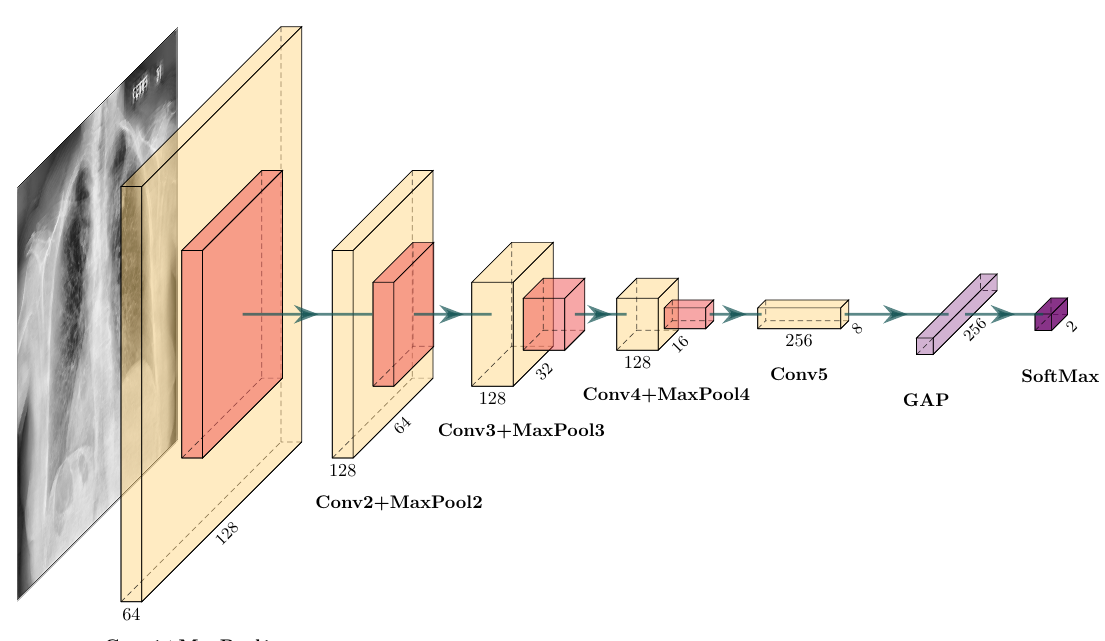
Figure 2. Diagram of COVID-XNet. It consists of five convolutional layers (Conv), four max pooling layers (MaxPool), a GAP layer, and a softmax layer. Conv1, Conv2, and Conv3 use five × five kernel size, while Conv4 and Conv5 use three × three. All MaxPool layers use 2 × 2